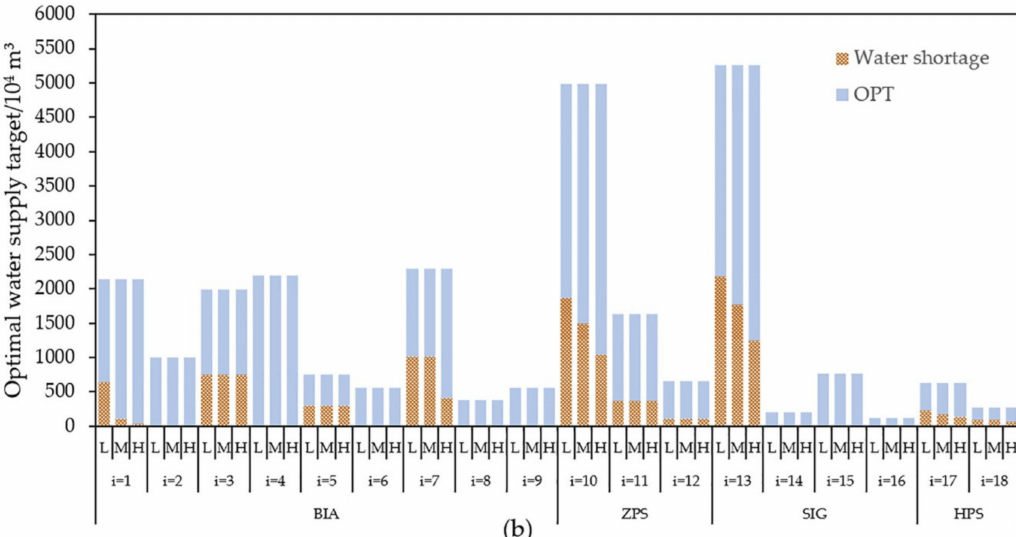
Figure 3. Water supply of each lake in the Momoge National Nature Reserve (MNNR) under di ff erent flood flow scenarios. Panel ( a ) shows the upper bound, while panel ( b ) shows the lower bound. L, M, and H denote low, middle, and high flow scenarios, respectively. The blue part represents the optimal actual water supply, while the red part represents a water shortage.